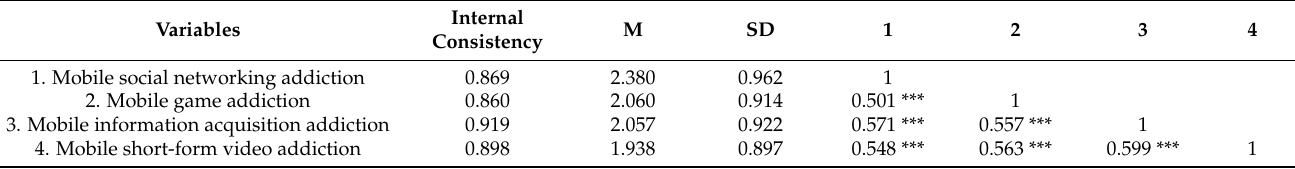
Table 4. Internal consistency coefficients and correlations between the four types of mobile phone